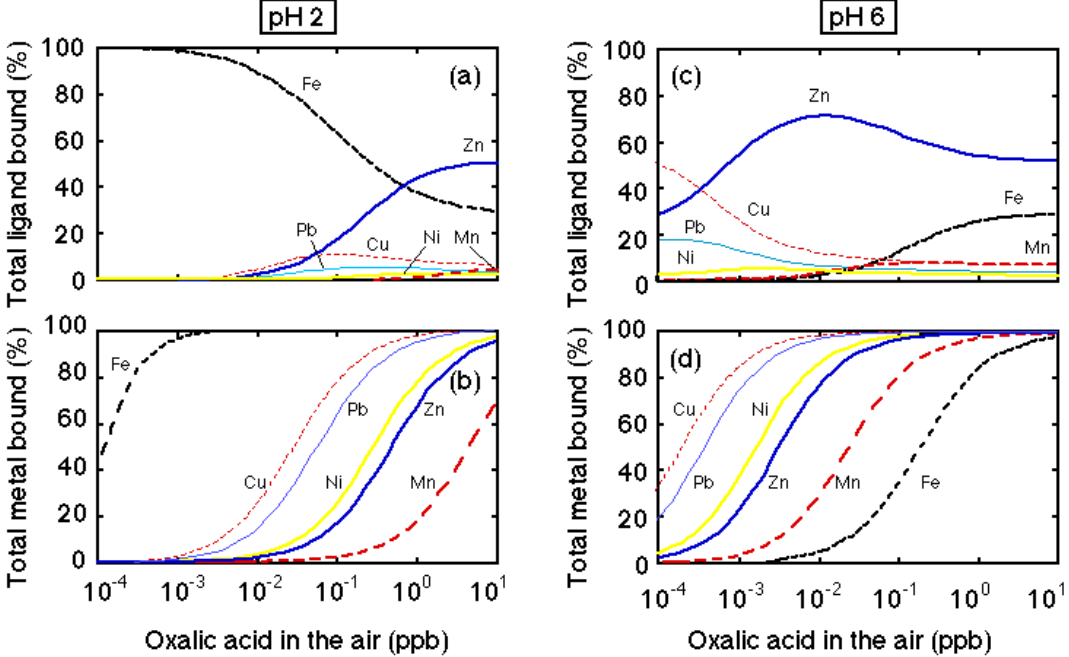
FIGURE 4 . Speciation of oxalic acid and metals in fog water: (a) speciation of oxalic acid in fog water with pH 2; (b) speciation of the metals in fog water with pH 2; (c) speciation of oxalic acid in fog water with pH 6; (d) speciation of the metals in fog water with pH 6. The calculation is made at LWC 10 –8 and the same concentrations of the metals as those in Fig.